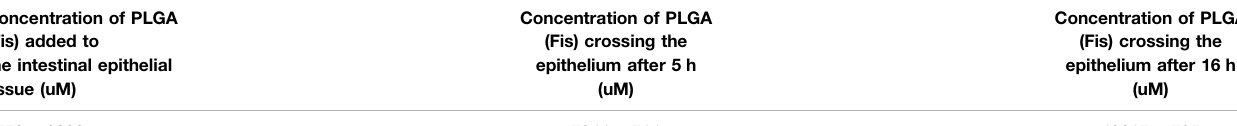
Concentration of PLGA (Fis) crossing the